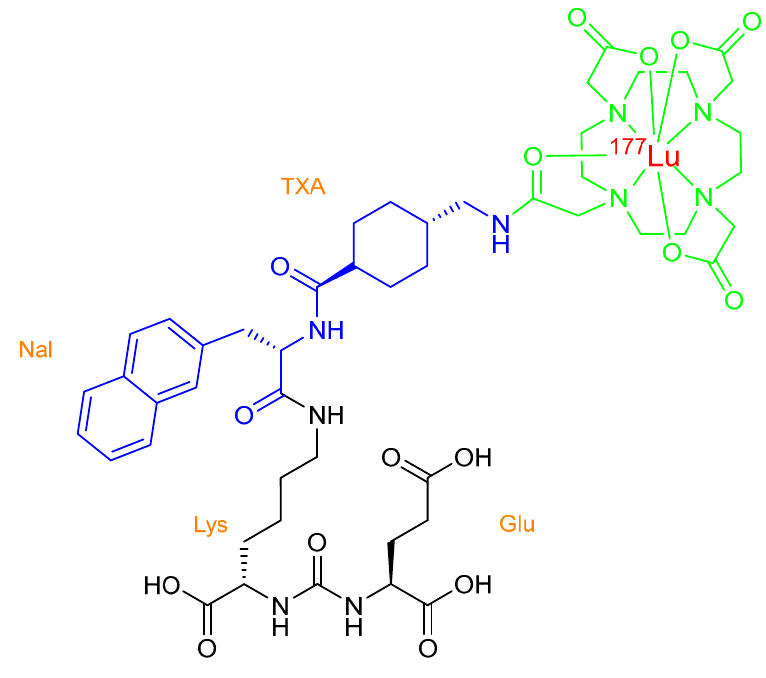
Figure 3. Chemical structure of [ 177